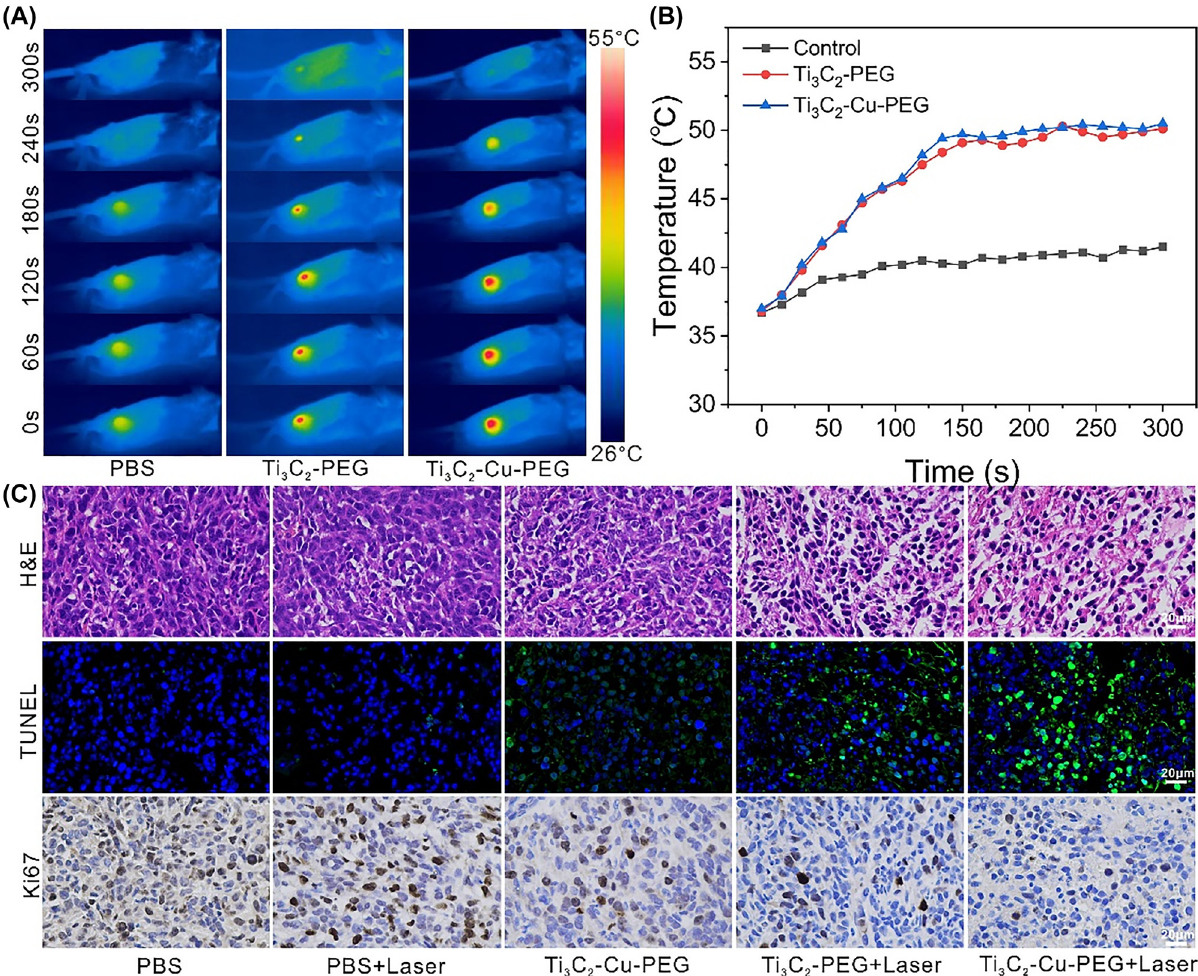
Figure 6: In vivo infrared thermography and tumor slices. (A) Infrared thermal images of 4T1 tumor-bearing mice and (B) temperature profiles of the tumors after intratumor injection of Ti TUNEL and Ki67 staining images of tumor slices collected from different groups 24 h post treatments.